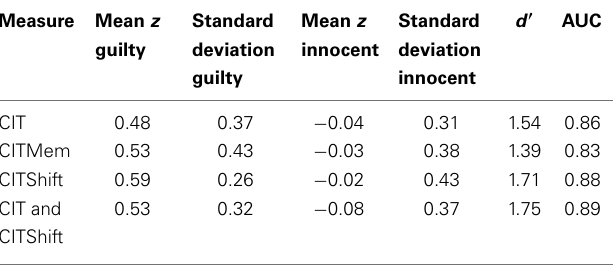
Table 1 reveals that d (cid:48) values for the CIT, CITMem, and CITShift were 1.54, 1.39, and 1.71, respectively.The d (cid:48) value for the combination of CIT and CITShift was 1.75. The areas under the ROC curve (AUC) were 0.86 for the CIT, 0.83 for the CITMem, 0.88 for the CITShift, and 0.89 for the combination between CIT and CITShift (all other combinations had equal or lower AUCs compared to individual